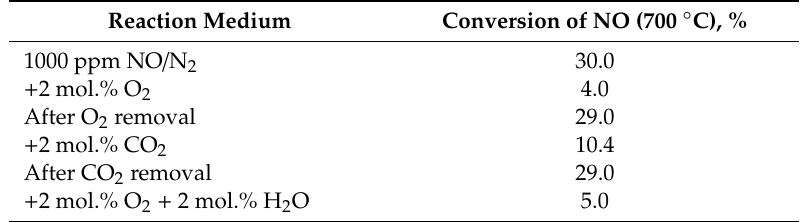
Table 7. Conversions of NO in the presence of O 2 , H 2 O, and a mixture of O 2 and H 2 O observed over the bare-Ce,K + Co,K